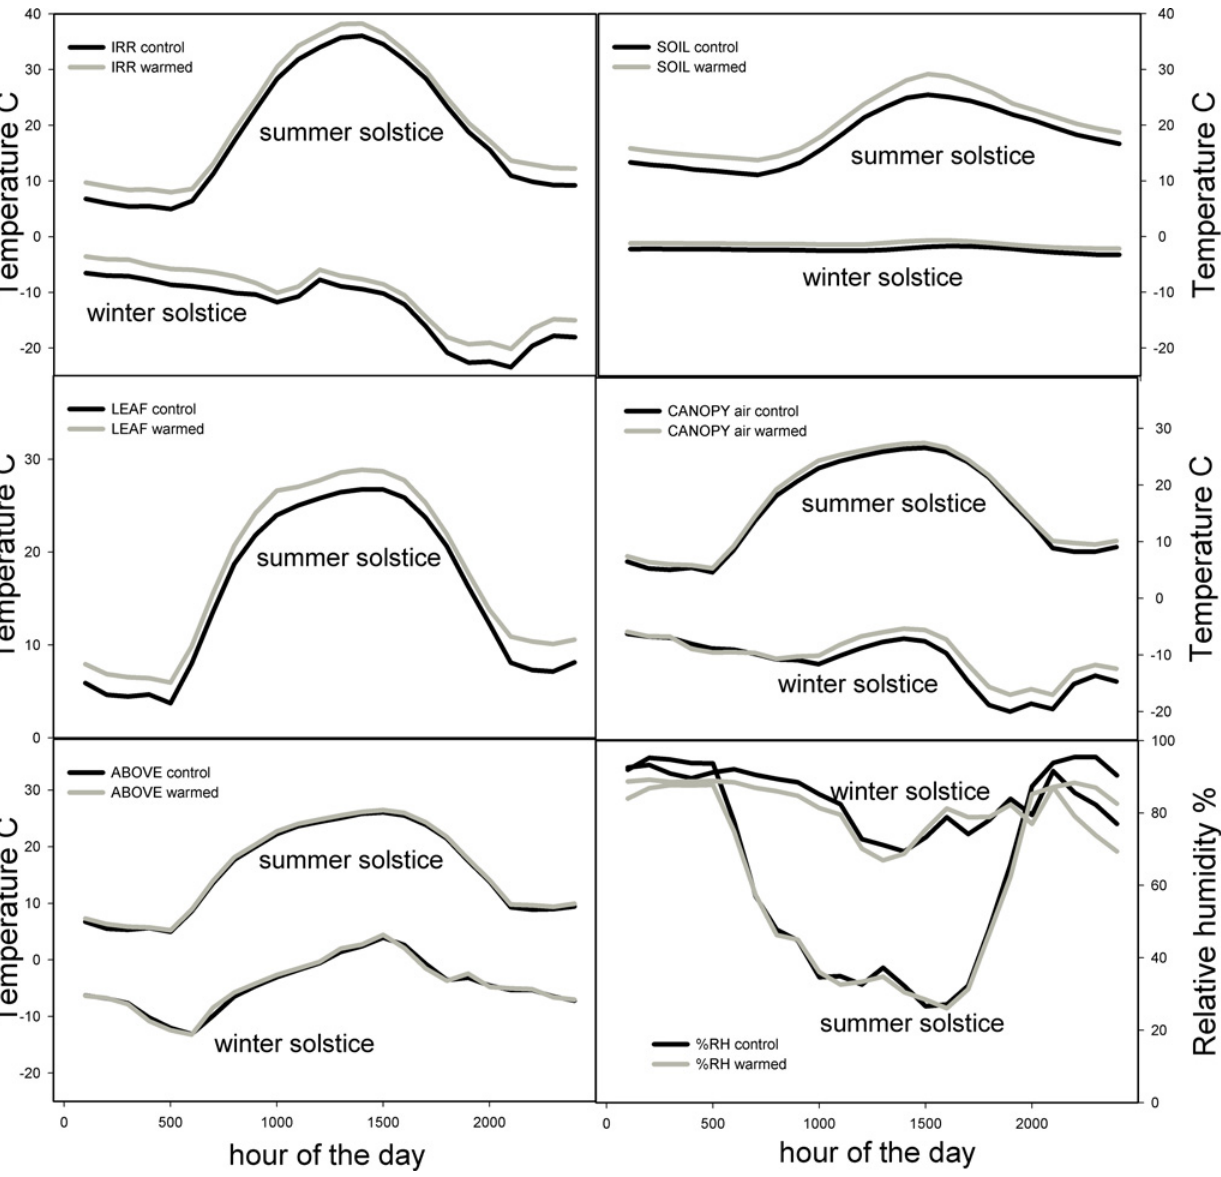
Figure 2. Effects of IR heaters on daily patterns of the vertical temperature profile in T-FACE experimental plots. Graphs show the diurnal patterns of five T-FACE microclimate temperatures and canopy relative humidity (15-minute averages) on the summer and winter solstice of 2011 at the Prairie Heating and CO 2 Enrichment experiment. Gray lines are the IR heater-warmed plots, black are the reference-control plots. The day target warming was 1.5°C and night 3.0°C. There were no LEAF thermocouples in the winter.